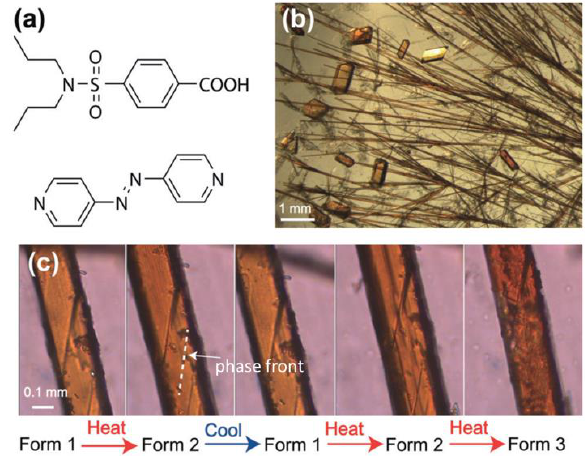
Figure 7. ( a ) Molecular structures of probenecid and 4,4′-azopyridine; ( b ) Optical microscopic image showing the crystal habits of the two polymorphs of the co-crystal, form 1 (acicular crystals) and form 3 (blocky crystals); ( c ) Thermal microscopy images showing the progression of the habit plane (phase front) during the reversible phase transition from form 1 to form 2 and during the irreversible phase transition from form 2 to form 3. Reprinted with permission from [66]. Copyright 2018, John Wiley &